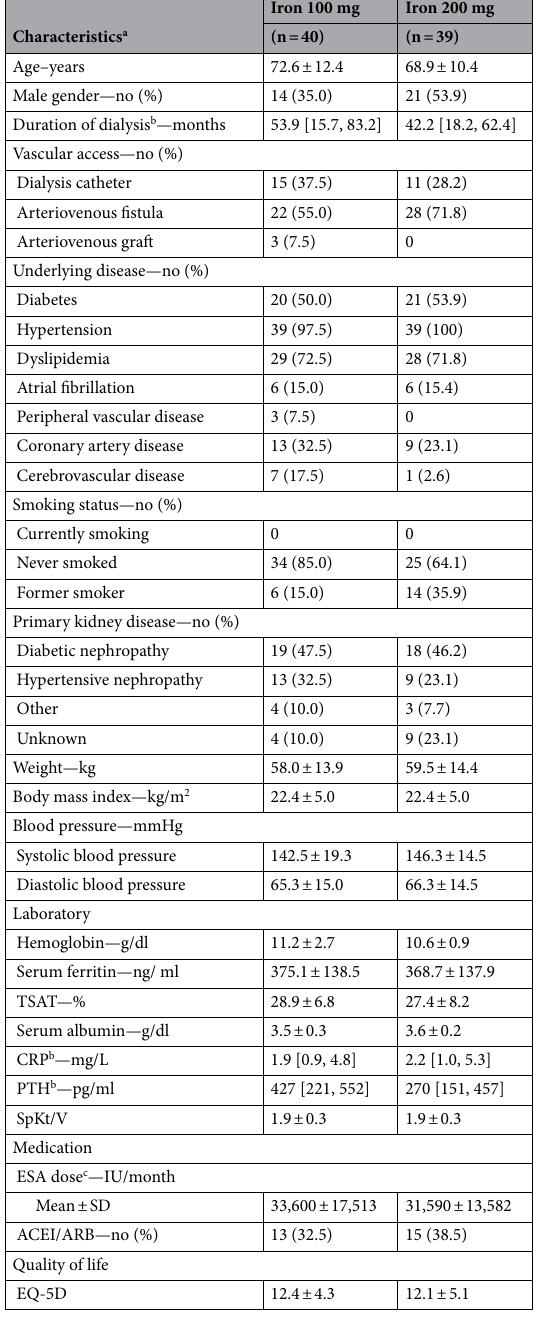
Table 1. Baseline characteristics of patients. TSAT, transferrin saturation; CRP, c-reactive protein; PTH, parathyroid hormone; SpKt/V, single-pooled Kt/V; ESA, erythropoiesis-stimulating agents; SD, standard deviation; IQR, interquartile range; ACEI, angiotensin-converting-enzyme inhibitor; ARB, angiotensin II receptor blocker. a Data are presented as mean ± standard deviation for continuous variables and number (percent) for categorical variables. Percentages may not total 100 due to rounding. b Non-normal distributed variables are presented as median [interquartile range]. c Commercial brands are Eprex, Recormon, Hypercrit, and